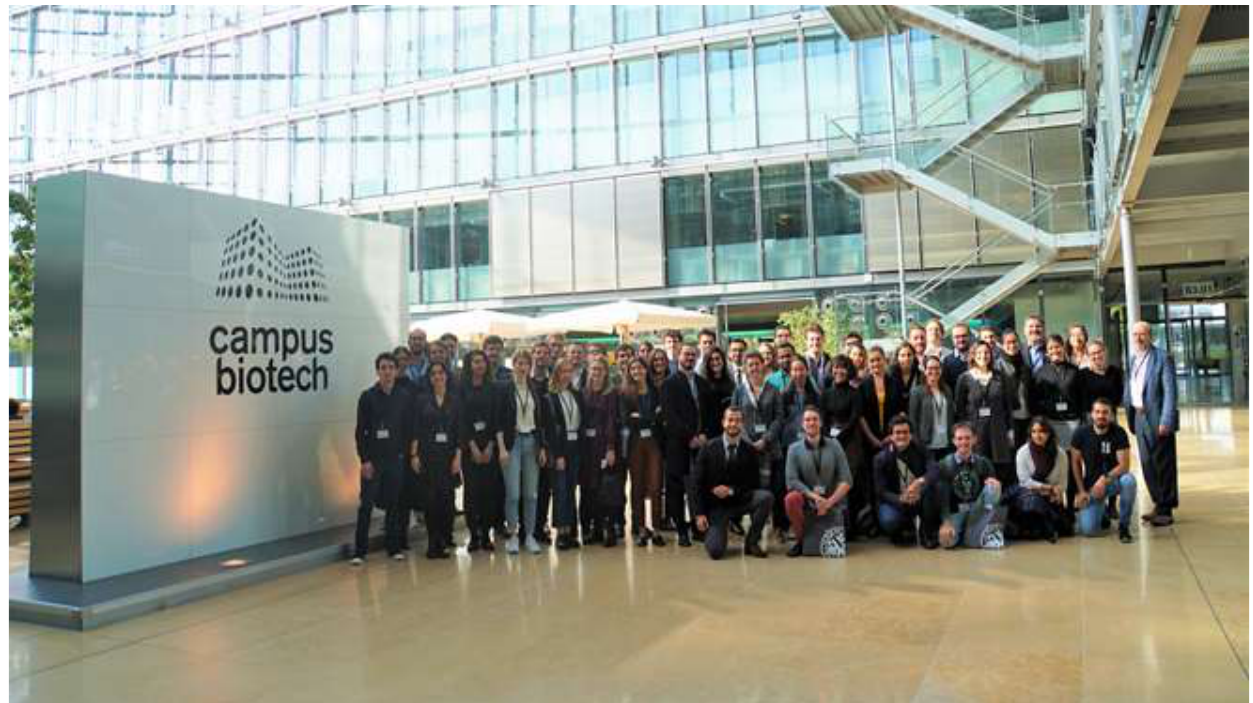
Figure 2. Delegates of the 8 th EU MD/PhD Association Conference. More than 70 delegates representing 15 nationalities attended the meeting at Campus Biotech, Geneva,